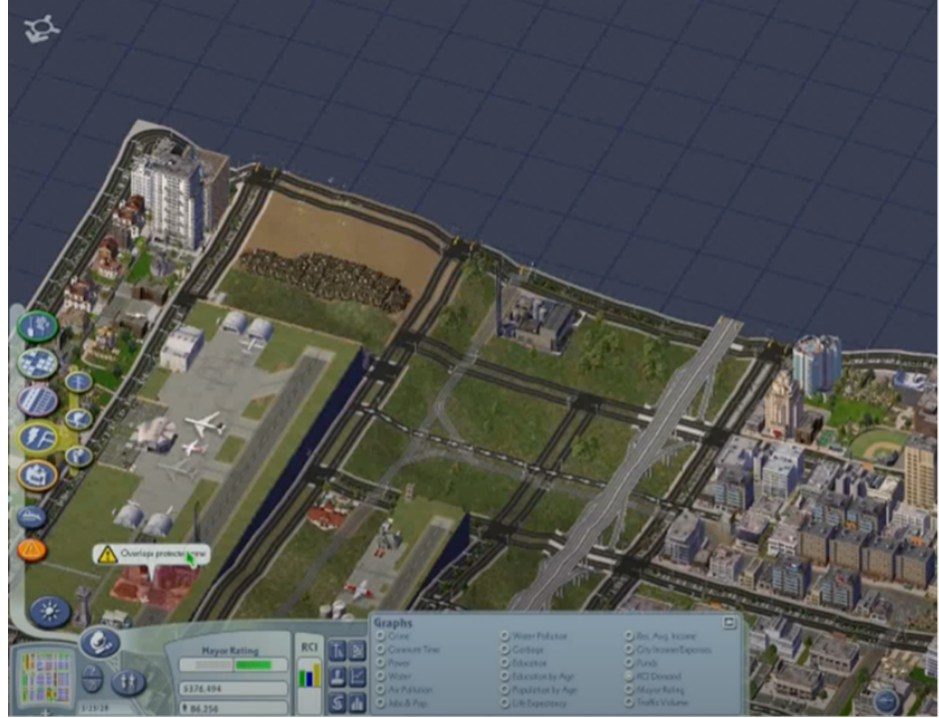
Figure 1. Landfill and waste-to-energy plant are potential options for waste management in SimCity 4